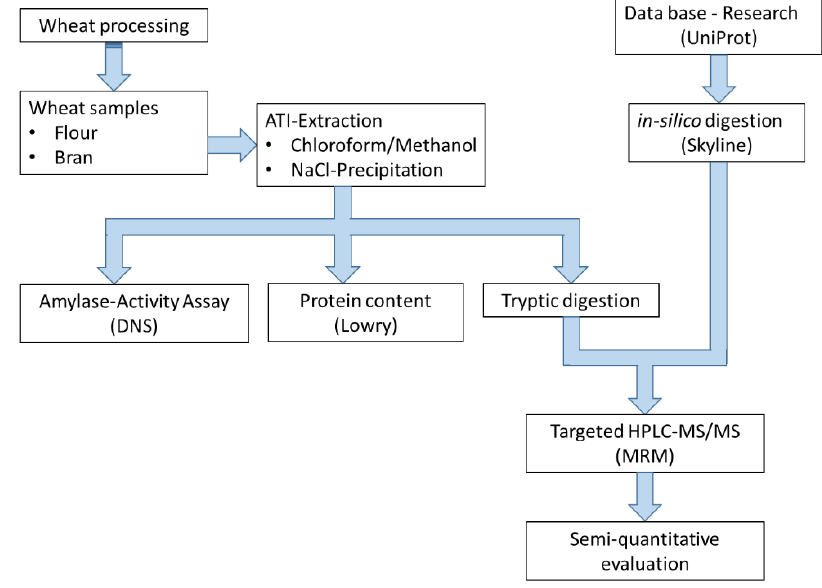
Figure 1. Workflow and methods applied for the analysis of α-amylase/trypsin Inhibitors (ATIs). Extraction was based on our recently published study [3] . DNS: α-amylase activity using a colorimetric method with 3,5-dinitrosalicylic acid reagent; Lowry: Assay for determining the protein content in in the extracted solutions; MRM: Multiple reaction monitoring